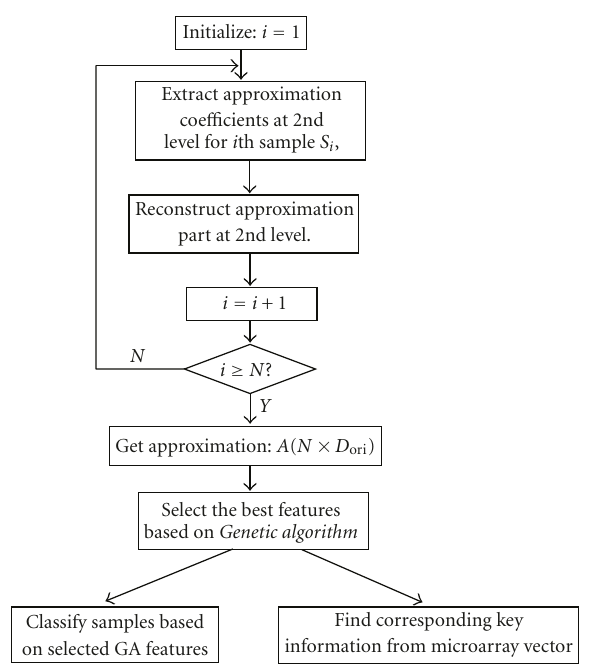
Figure 5: The method of finding significant information of microarray vector based on wavelet reconstructed information. N , D ori represent the number of samples and original dimension number of microarray vectors,